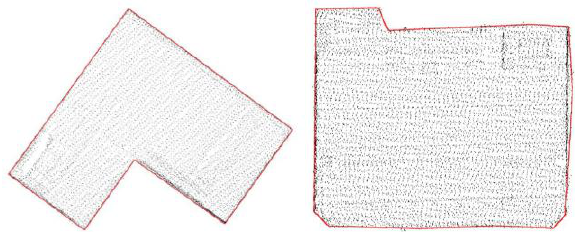
Figure 7. Building outlines after